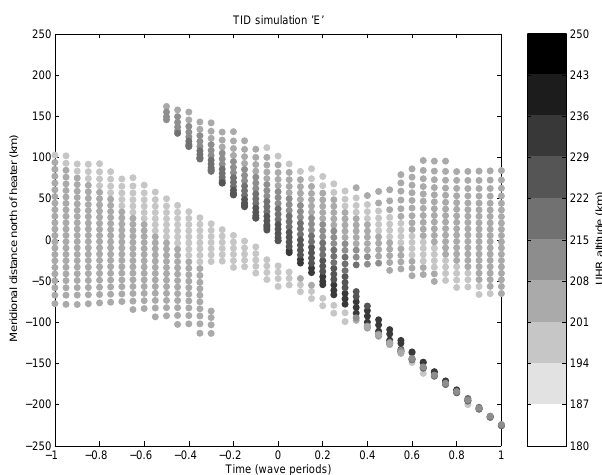
Fig. 4. Simulation of how the region where the HF pump reaches the upper-hybrid resonance altitude varies as the TID “E” passes over the transmitter location. Time zero corresponds to the time when the envelope peak is directly above the transmitter. Each cir- cle represents the location where an up-going pump ray intersects the upper-hybrid resonance